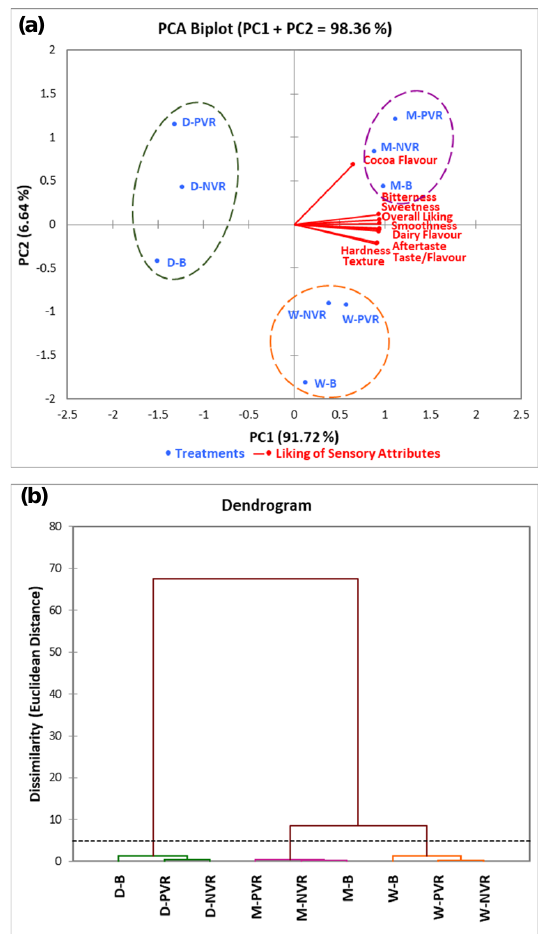
Figure 7. ( a ) Principal component analysis (PCA) biplot regarding liking scores 1 of chocolate attributes in different environments 2 ; ( b ) Dendrogram of agglomerative hierarchical clustering (AHC) grouping chocolate products under different environments 2 . 1 Liking scores were based on the 9-point hedonic scale (1 = dislike extremely, 5 = neither like nor dislike, 9 = like extremely) [19]. 2 M-PVR: milk chocolate positive VR; M-NVR: milk chocolate negative VR; M-B: milk chocolate sensory booth; W-PVR: white chocolate positive VR; W-NVR: white chocolate negative VR; W-B: white chocolate sensory booth; D-PVR: dark chocolate positive VR; D-NVR: dark chocolate negative VR; D-B: dark chocolate sensory